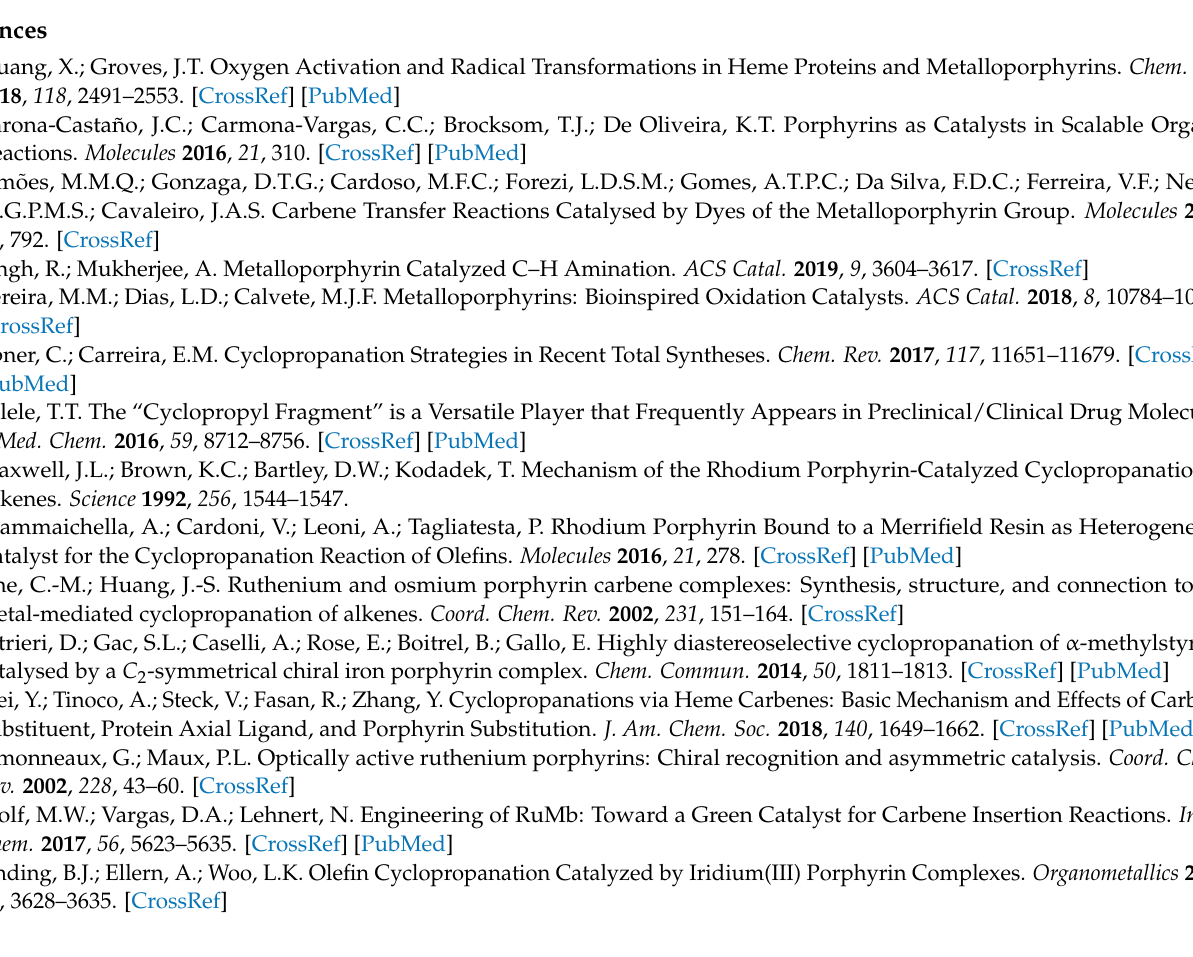
Table S7: Cartesian coordinates of B in the doublet state of Co(NCTPPSpy) .; Table S8: Cartesian coor- dinates of TS1 trans in the doublet state of Co(NCTPPSpy) .; Table S9: Cartesian coordinates of TS1 cis in the doublet state of Co(NCTPPSpy) .; Table S10: Cartesian coordinates of C trans in the doublet state of Co(NCTPPSpy) .; Table S11: Cartesian coordinates of C cis in the doublet state of Co(NCTPPSpy) .; Table S12: Cartesian coordinates of TS2 trans in the doublet state of Co(NCTPPSpy) .; Table S13: Cartesian coordinates of TS2 cis in the doublet state of Co(NCTPPSpy) .; Table S14: Cartesian coordi- nates of PC trans in the doublet state of Co(NCTPPSpy) .; Table S15: Cartesian coordinates of PC cis in the doublet state of Co(NCTPPSpy) .; Table S16: Cartesian coordinates of TSi in the doublet state of Co(NCTPPSpy)